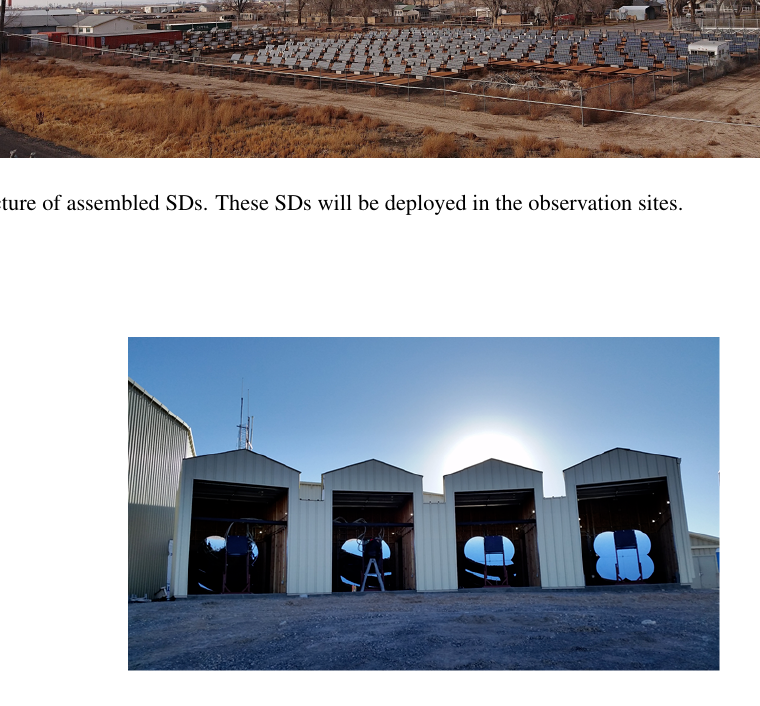
Figure 2. Picture of assembled 4 telescopes in the FD station at the north site of the TAx4